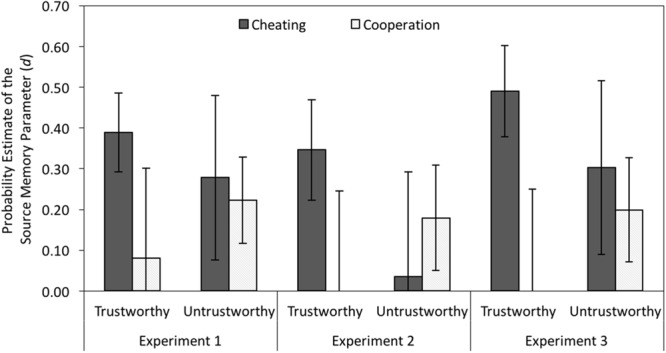
Estimates of the source memory parameter d as a function of the partners’ facial trustworthiness (trustworthy vs. untrustworthy) and the partners’ behavior (cheating vs. cooperation) in Experiment 1 (without cognitive load) and in Experiments 2 and 3 (with cognitive load). The error bars represent the 95% confidence intervals.